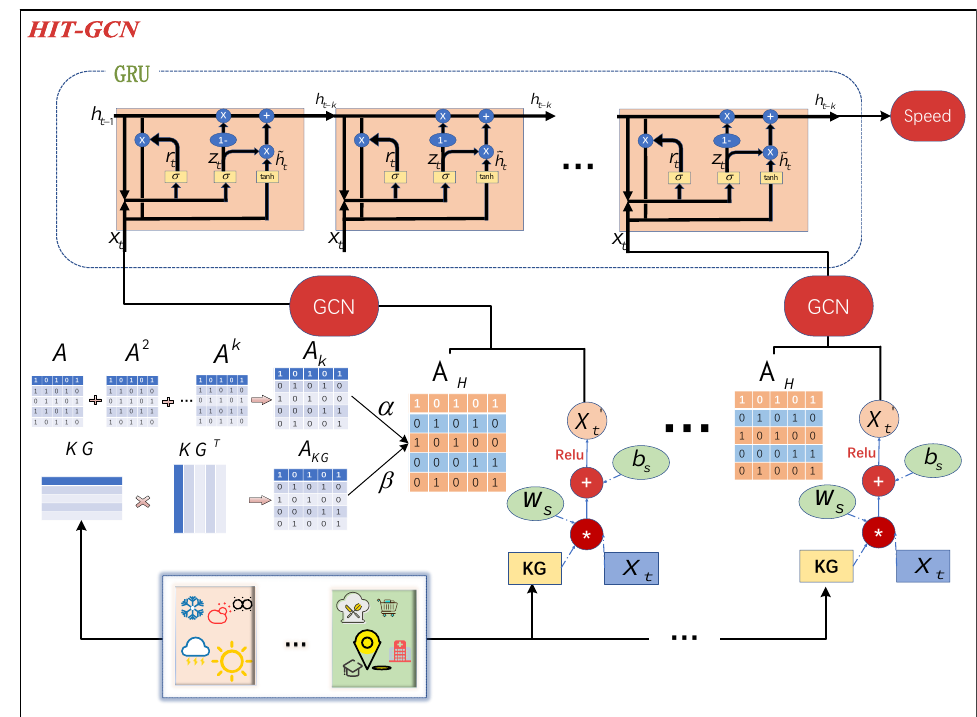
Figure 1. The framework of the proposed